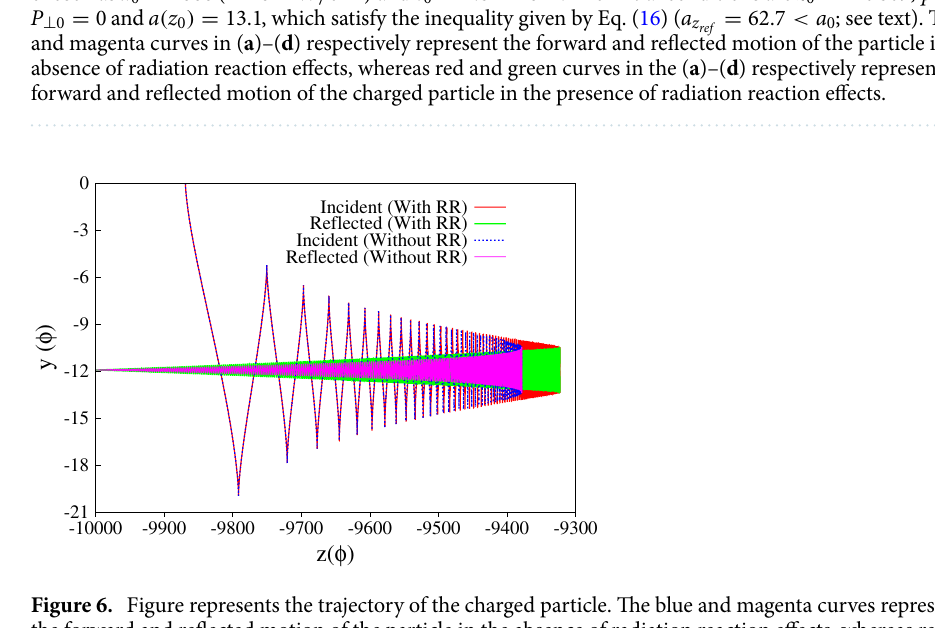
respect to “z” co-ordinate and Fig. 6 represents the trajectory of the particle. In all the figures the blue and magenta curves respectively represent the forward and reflected motion of the particle in the absence of radiation reaction effects, whereas red and green curves respectively represent the forward and reflected motion of the charged particle in the presence of radiation reaction effects. It is clearly seen from these figures that the particle reflects from the focal region even in the presence of radiation reaction effects (radiation reaction just pushes